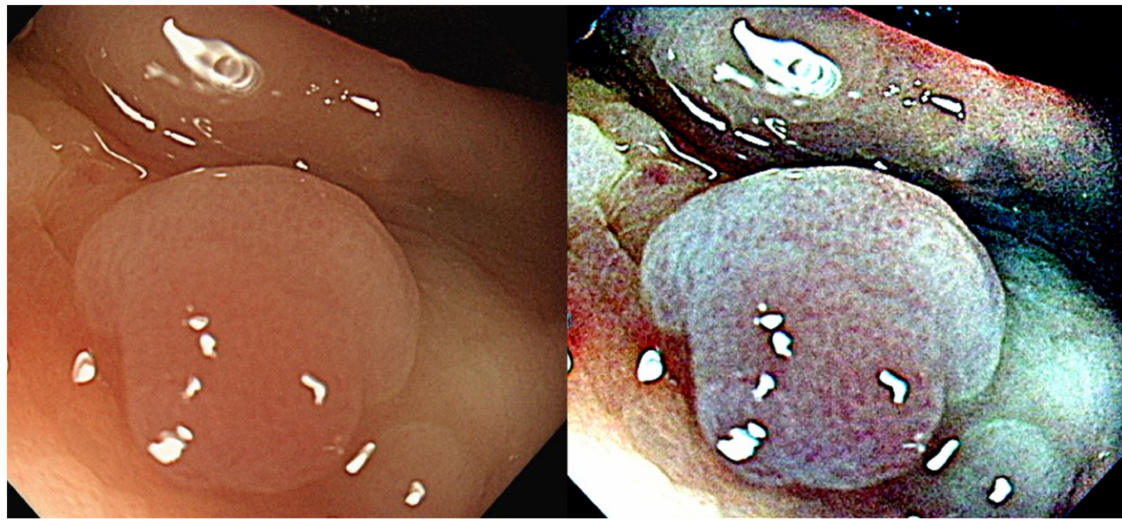
Figure 7. Images of SSA polyp after Retinex. (( Left ): Original WL, ( Right ):